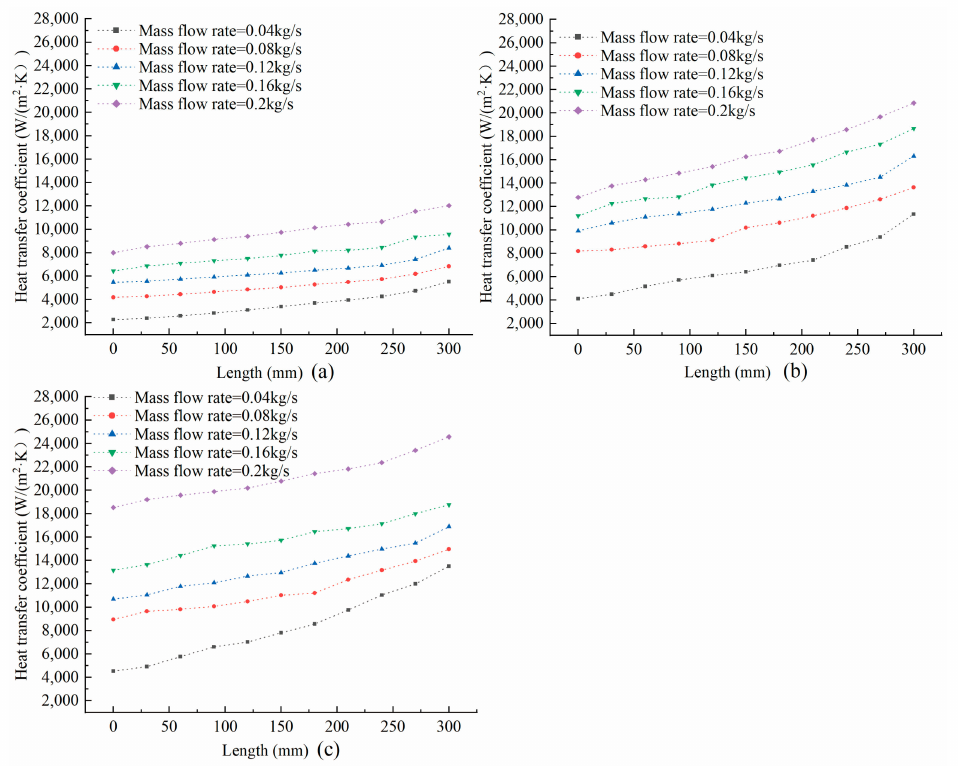
Figure 6. Effect of mass flow rate on the HTC at T water.inlet = 320 K for three different tubes. Smooth tube ( a ), corrugated tube with circular corrugations ( b ), and corrugated tube with rectangular corrugations ( c ).